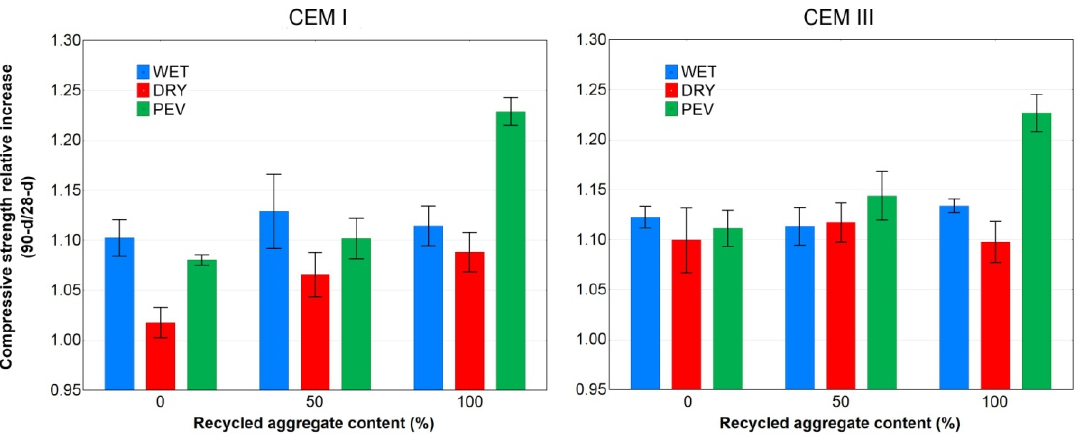
Figure 4. Compressive strength of concrete after 28 and 90 days.